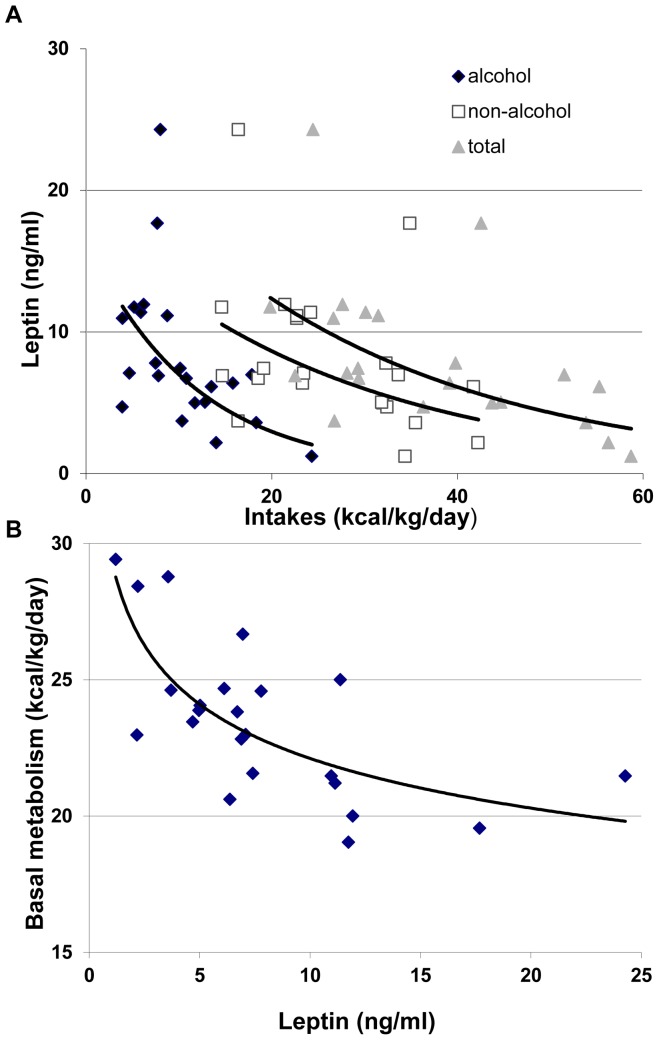
Relation between leptinemia and intakes (A) and between leptinemia and basal metabolism (B).